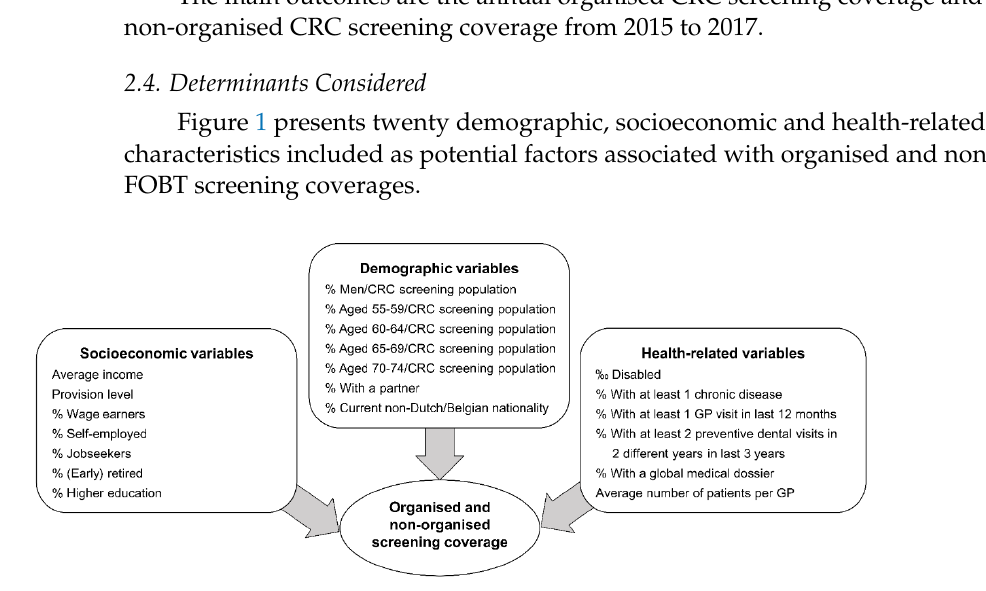
Figure 1. Potential municipal characteristics associated with organised and non-organised colorectal cancer screening using faecal occult blood test.